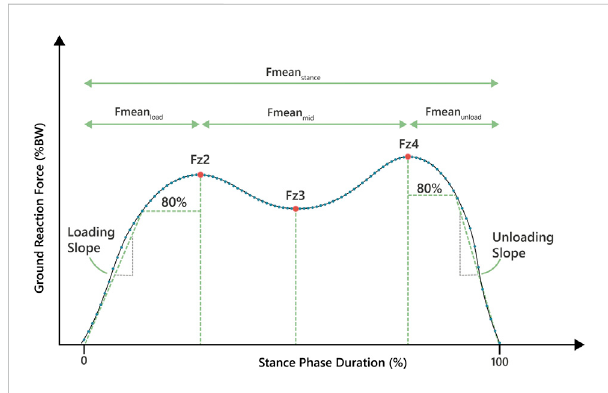
FIGURE 1 The plantar pressure gait curve with the determined parameters.